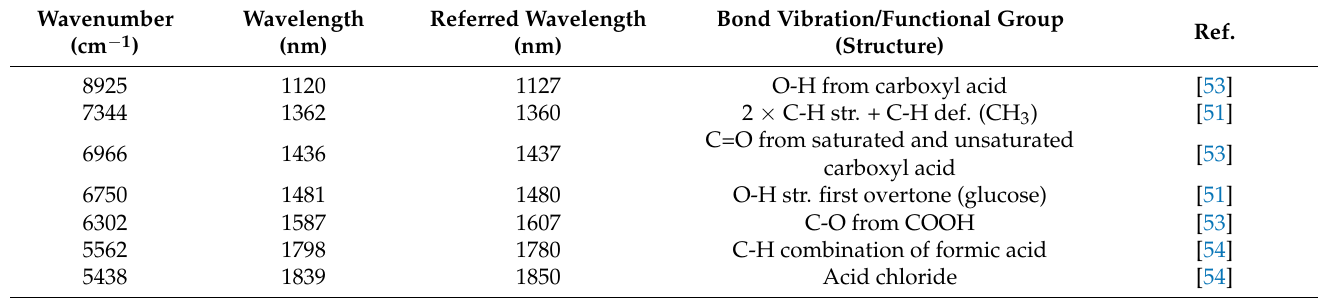
Table 10. The bands with a high-regression coefficient of the PLSR model for TA in mango pur é e. Wavenumber